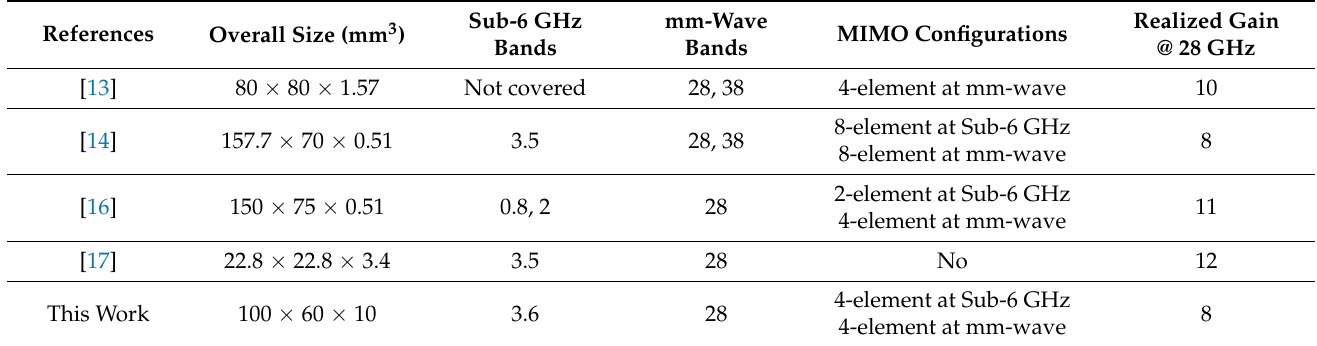
Table 1. Comparison of the proposed MIMO antenna design with state-of-the-art